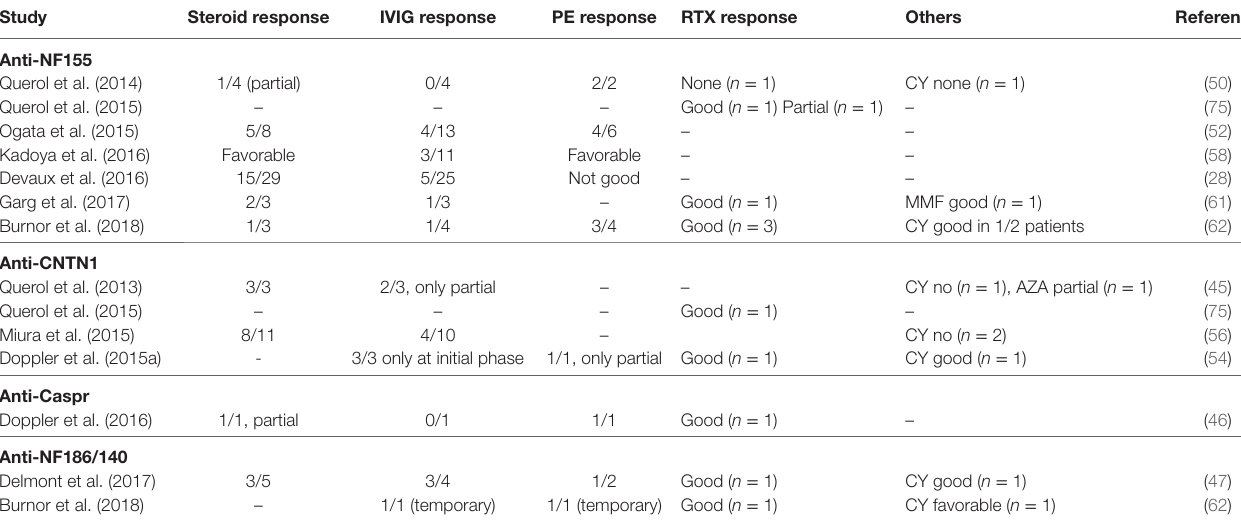
TABLe 7 | Treatment response in seropositive chronic inflammatory demyelinating polyneuropathy